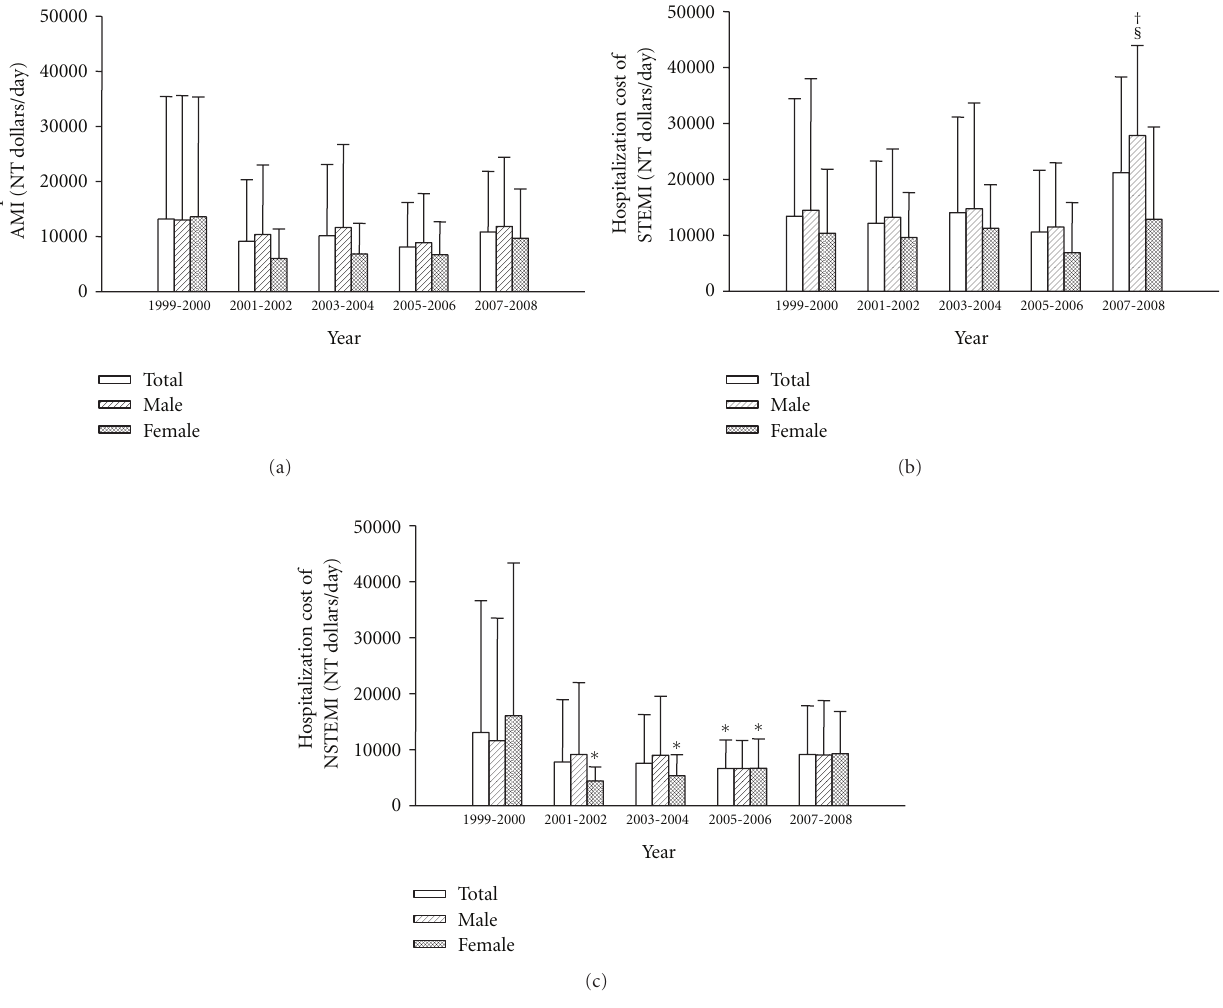
Figure 3: Hospitalization cost of total, male, and female acute myocardial infarction (AMI, (a)), ST elevation MI (STEMI, (b)), or non-ST elevation MI (NSTEMI, (c)) from 1999 to 2008. ∗ P < 0 . 05 versus 1999 ∼ 2000, † P < 0 . 05 versus 2001 ∼ 2002, and § P < 0 . 05 versus 2005 ∼ 2006.